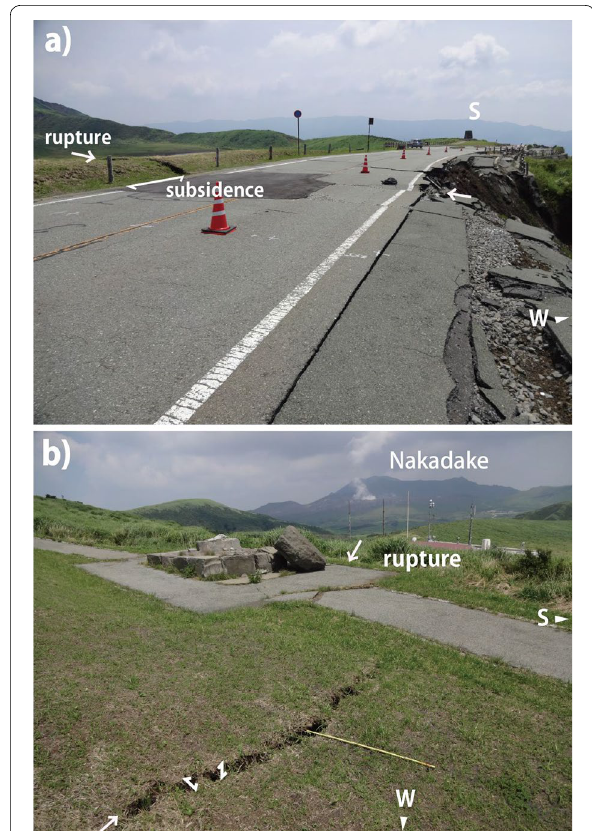
Fig. 6 Surface rupture at north Kusasenrigahama. a Surface rupture appearing at Site 45. The subsidence rupture created negative values of 12 cm on the north side and 20 cm on the south side. b Subsid- ence rupture in a showing change to linear rupture continuity. The displacement is 8 cm south side down and 7 cm at the